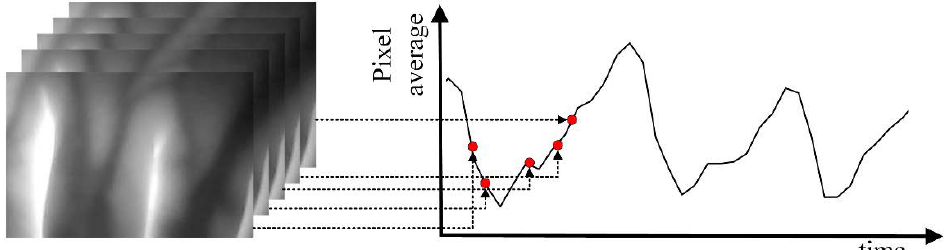
Figure 3. Principle diagram of pulse wave signal acquisition.